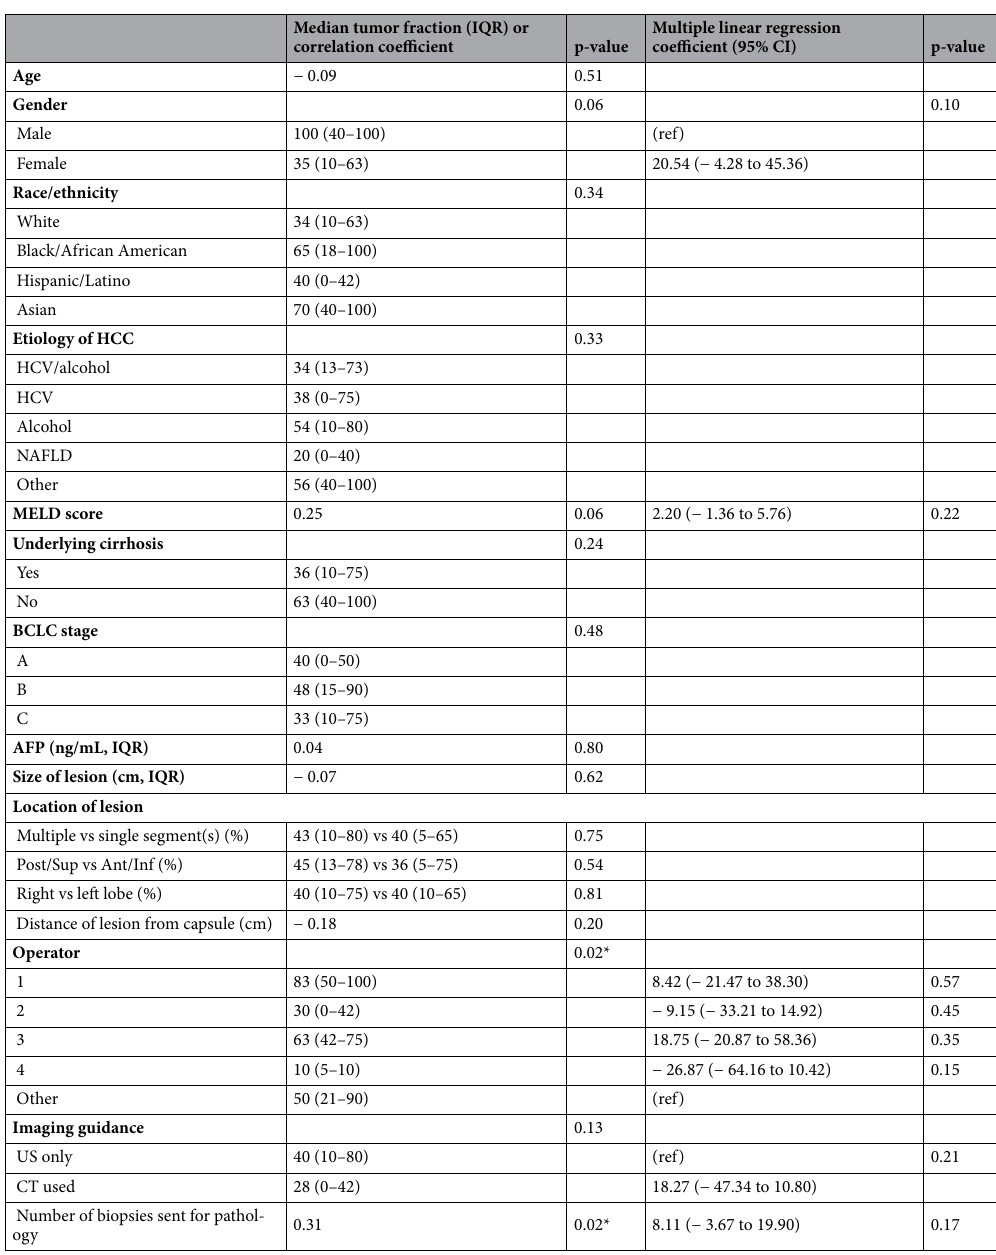
Table 2. Factors associated with biopsy